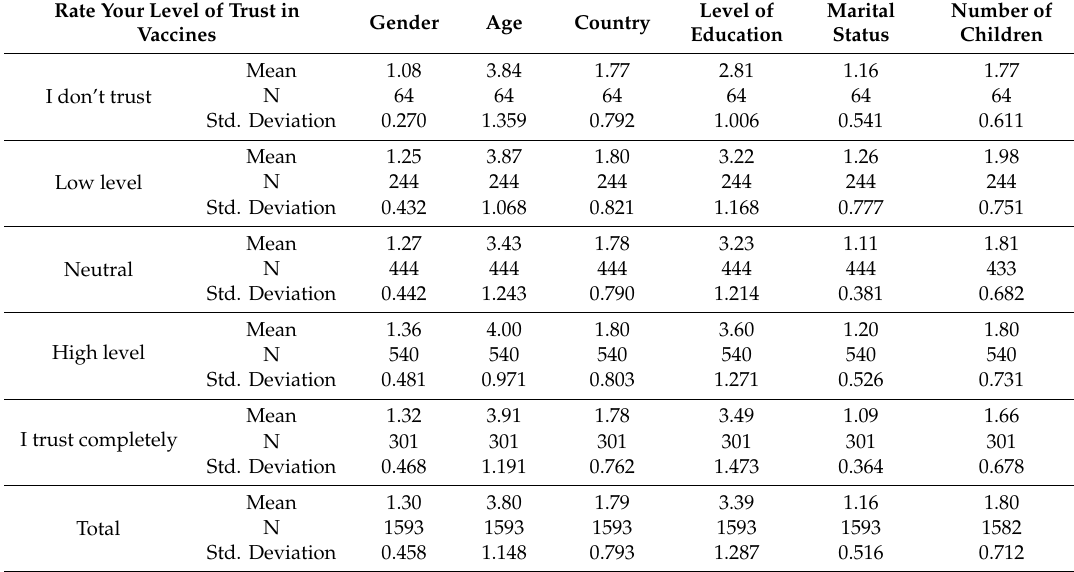
Table 2. Table of contingency for attitudes, i.e., trust in vaccines in relation to the characteristics of the